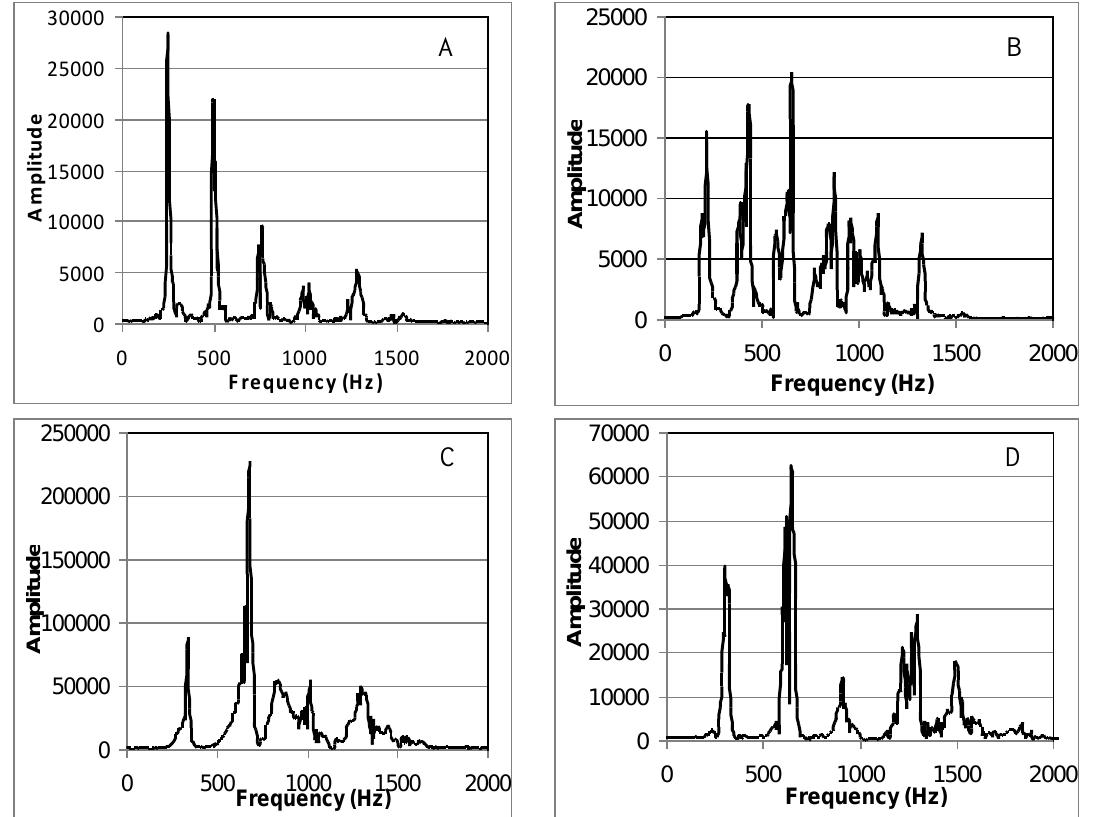
Fig. 5: Amplitude versus frequency plot for four voice samples from M12, M10, F9 and F6 (A, B, C, D) respectively while pronouncing the word ‘Four’. Table 1: Prominent frequencies produced by four subjects. Prominent Frequencies of Frequency